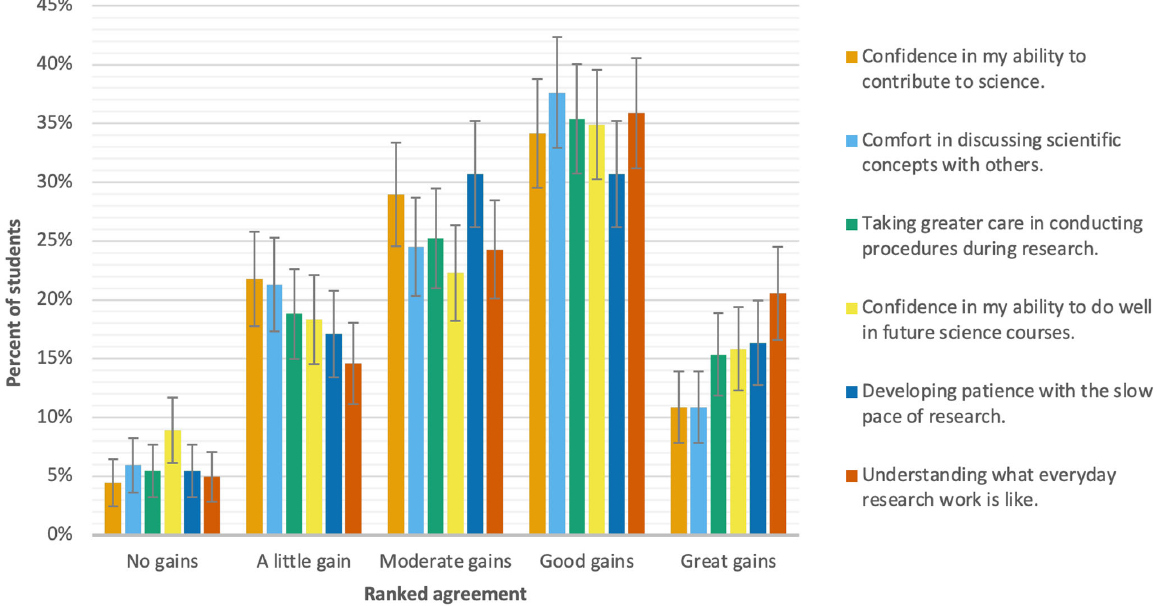
TABLE II. Student reported gains of research skills, confidence, and understanding from the URSSA survey [88] with 1 = no gain; 2 = a little gain; 3 = moderate gains; 4 = good gain; 5 = great gain. The Phys-1140 CURE is compared to student responses from two previous studies of students in traditional undergraduate research experiences.